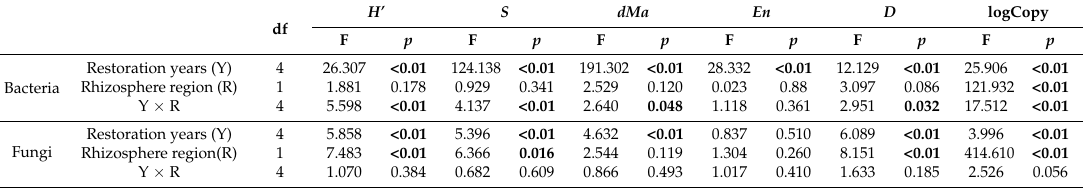
Table 4. Two-way ANOVA of microbial diversity and microbial gene abundances of rhizosphere and non-rhizosphere soil in different sub-dams.